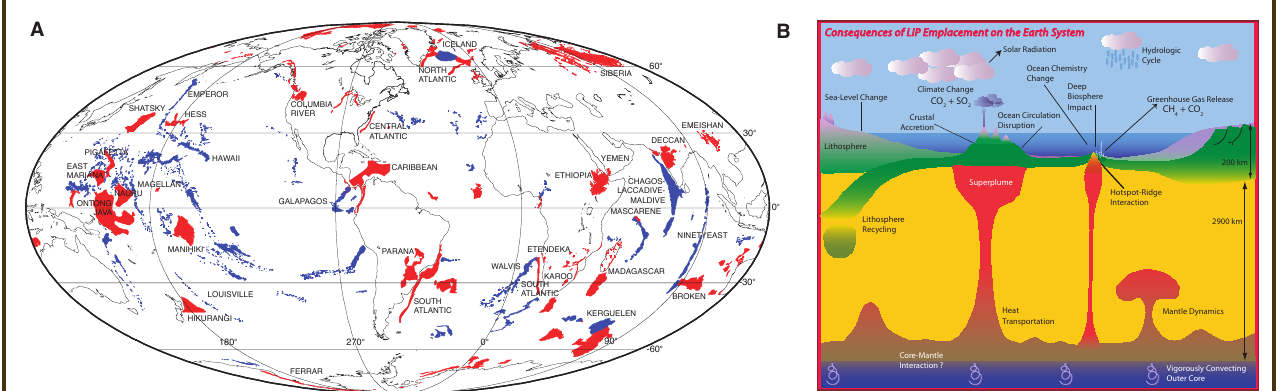
Figure 1. [A] Phanerozoic global LIP distribution. Red = LIPs (or portions thereof) generated by a transient “plume head”; Blue = LIPs (or portions thereof) generated by a persistent “plume tail”. Taken from Coffin (2006). [B] A holistic representation of the process of LIP emplacement and associated environmental